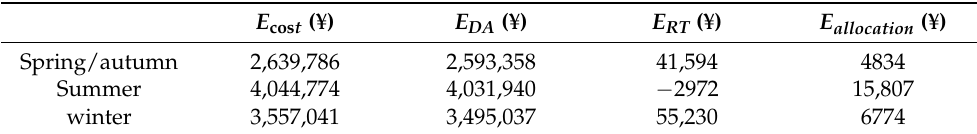
Table 8. Electricity charges without comprehensive optimization algorithm.